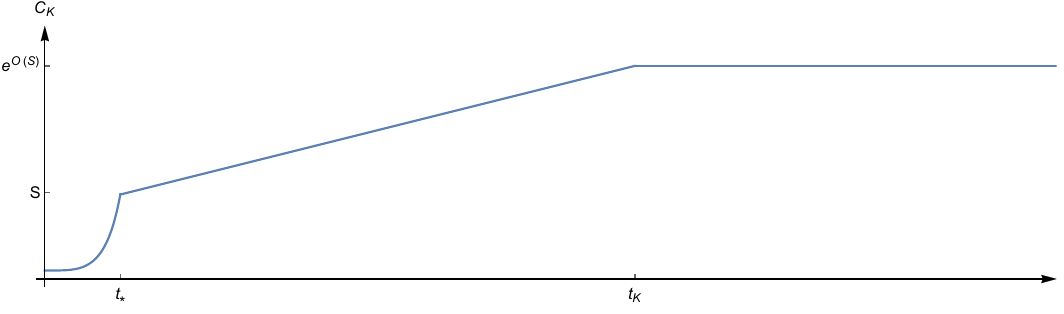
Figure 2 . Evolution of K-complexity for a fast scrambler of size S , featuring an exponential law in the pre-scrambling era t < t (cid:3) (cid:24) (cid:21) (cid:0) 1 log S , followed by a linear law in the post-scrambling era, up to t K (cid:24) e O ( S ) =(cid:21)S , when the complexity (cid:12)nally